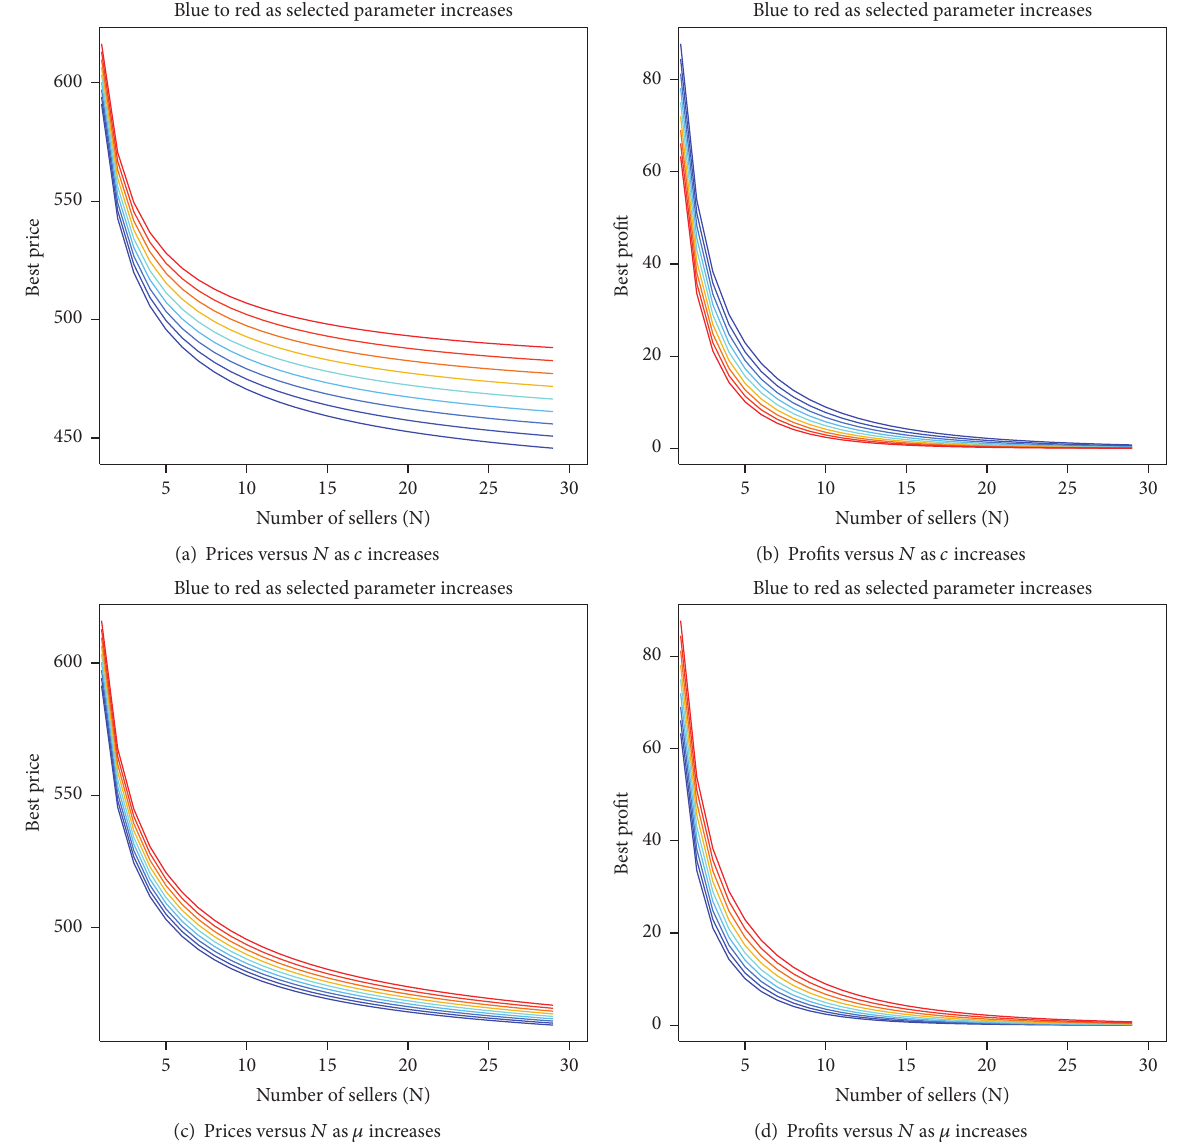
Figure 1: Responses in optimal price and (expected) profits to changes in cost 𝑐 , price mean 𝜇 , and market size 𝑁 . From blue to red as cost and price mean increase within the range of analysis and with parameter values as in the benchmark case ( 𝜇 = 600, 𝜎 2 = 125, ] = 2 , 𝑁 = 30 ); see Table